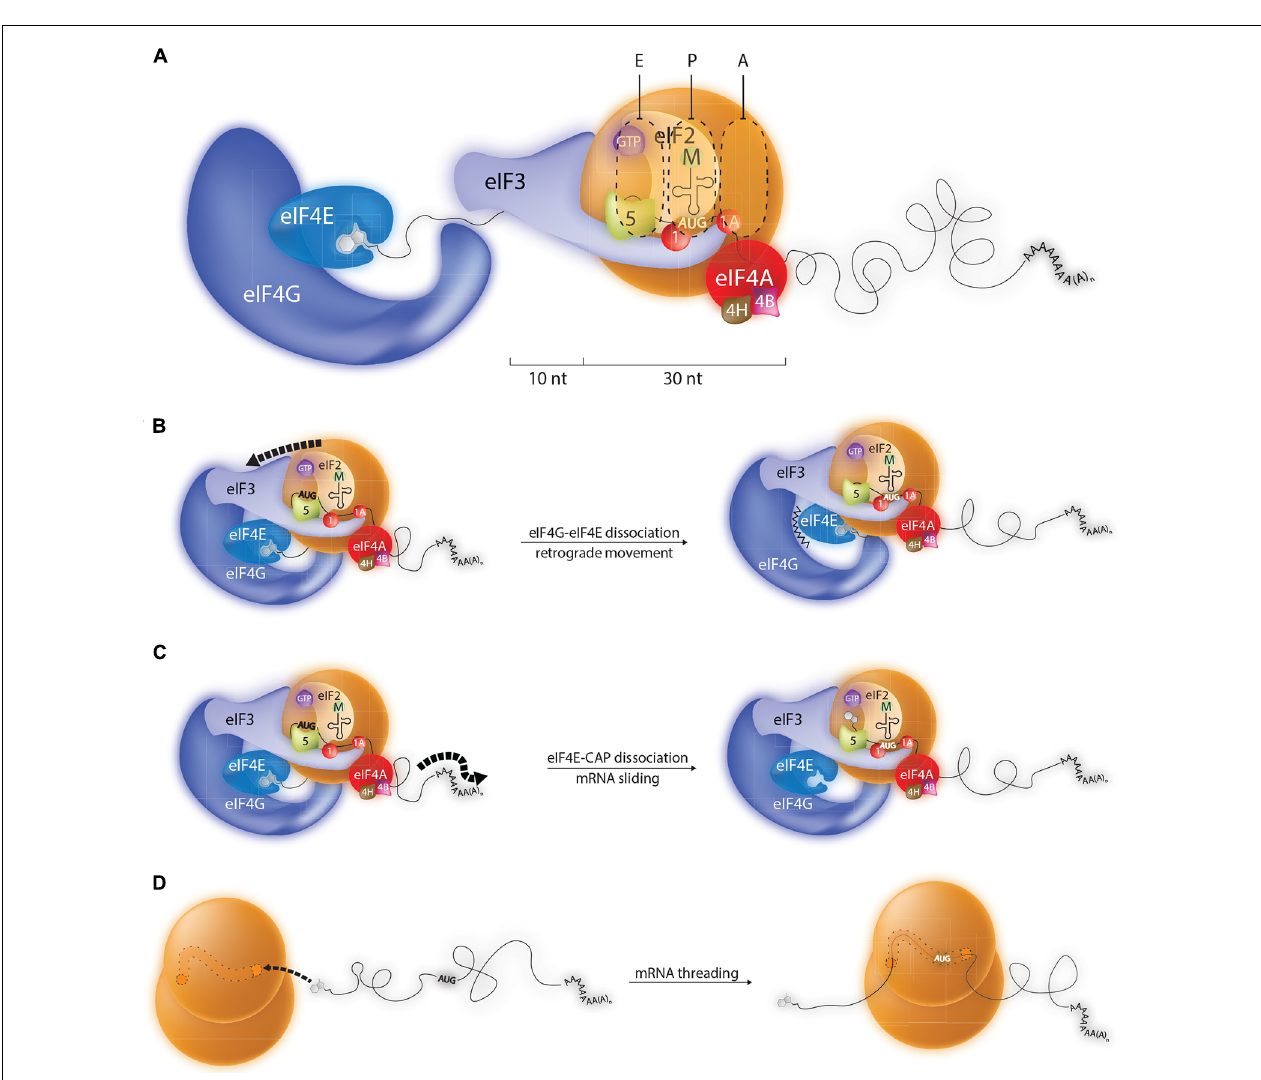
FIGURE 2 | Possible mechanisms by which the ribosome can recognize initiation codons close to the 5 (cid:48) cap. (A) During conventional scanning the 43S ribosome will move 5 (cid:48) –3 (cid:48) on the mRNA until it positions an initiation codon in the P site. Probing studies indicate that the 43S paused over an AUG start codon makes contacts with around 40 nts of mRNA, 10 upstream nts of which are in close contact with eIF3. Such a configuration explains why AUG codons within the first 20 nts of most mammalian transcripts are poorly recognized by the ribosome. However, a number of models can be evoked to explain the initiation events observed on mRNA carrying TISU elements (translation initiation on short 5 (cid:48) UTRs) which have 5 (cid:48) TLs shorter than 10 nts. (B) Model 1: The eIF4E/4G contact is broken permitting retrograde movement (3 (cid:48) –5 (cid:48) ) of the PIC. (C) Model 2: The eIF4E-5 (cid:48) cap interaction is disrupted allowing the mRNA to slide over the surface of the 43S ribosome until the AUG enters the P site. (D) Model 3: Transcripts carrying 5 (cid:48) TISU elements are selectively recruited to empty 80S ribosomes and then treaded through the mRNA channel until the AUG enters the P site.